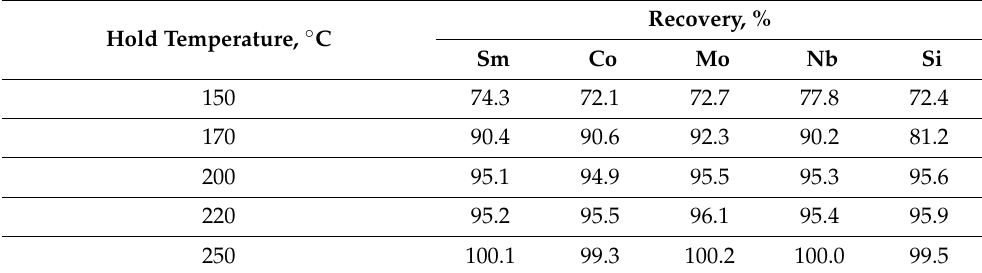
Table 4. The recovery of the elements, by hold temperature. Hold Temperature, ◦